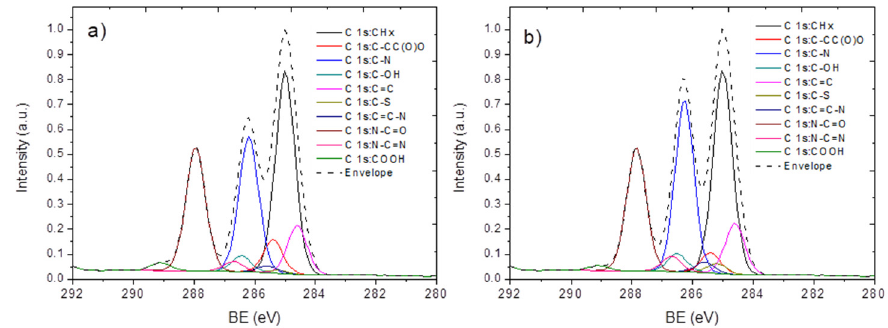
Figure 4. The calculated XPS C1s spectra of apoliprotein A1 ( a ) and human recombinant angiogenin ( b